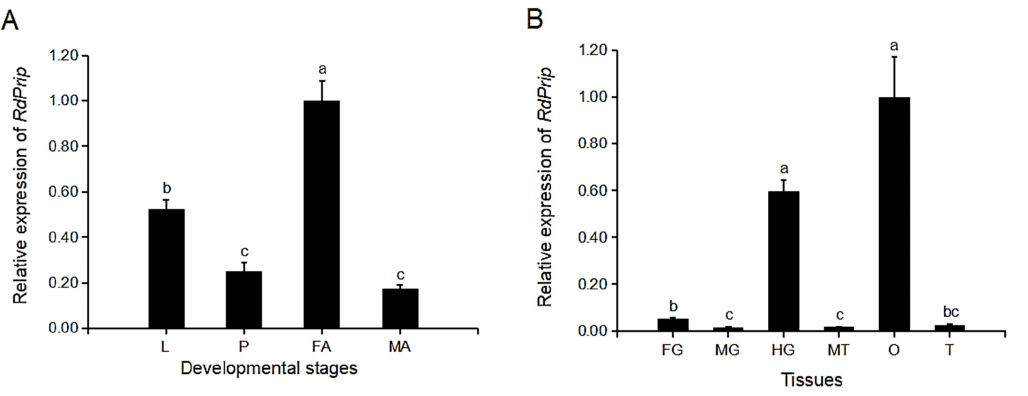
Figure 2. Developmental ( A ) and tissue ( B ) profiles of RdPrip expression. The error bar represents the standard error of three replicates. Different letters indicate significant differences between treat ‐ ments ( p < 0.05). L: larvae; P: pupae; FA: female adults; MA: male adults; FG: foregut; MG: midgut; HG: hindgut, including cryptonephridial systems; MT: Malpighian tubules; O: ovary; T: testis.